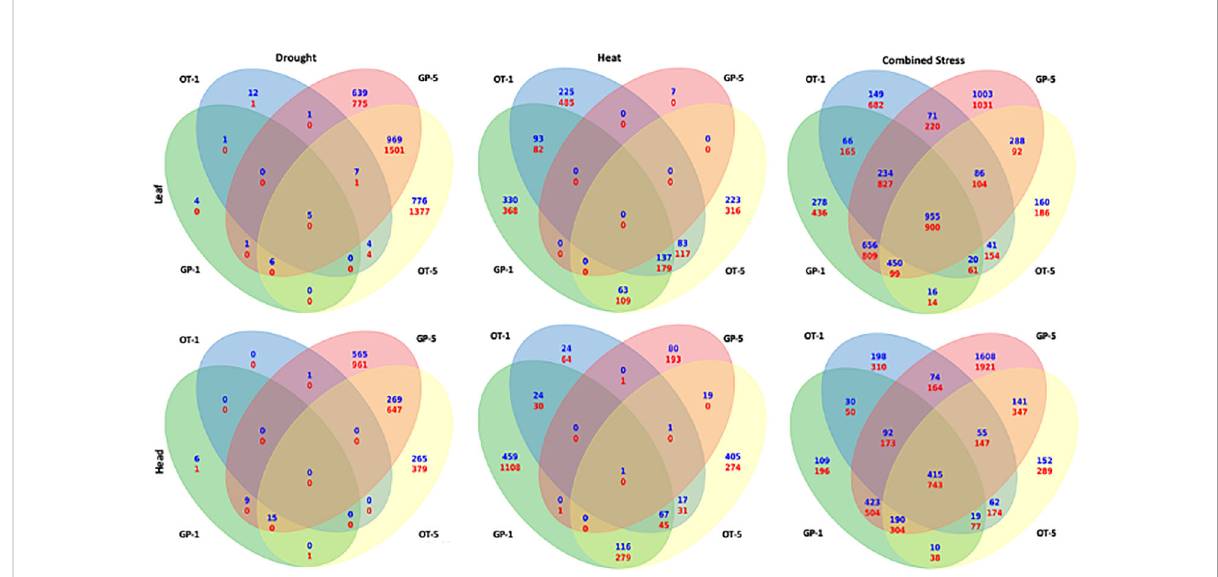
FIGURE 6 Venn diagram showing the overlap between DEGs responsive to drought (left), heat (middle), and combined stress (right). The top panel shows the comparisons from the leaf libraries and the bottom panel shows the comparisons from head libraries. In each Venn diagram the left side